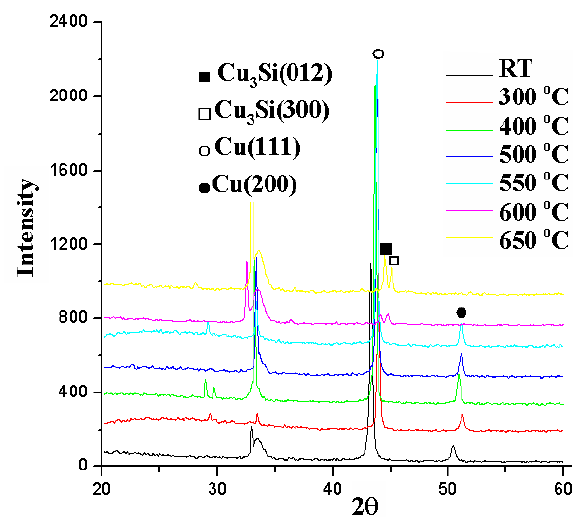
Figure 15. X-ray diffraction patterns for the structures of MgO (0.5 nm) sample annealed for 5 min at temperatures from room temperature to 650 °C.